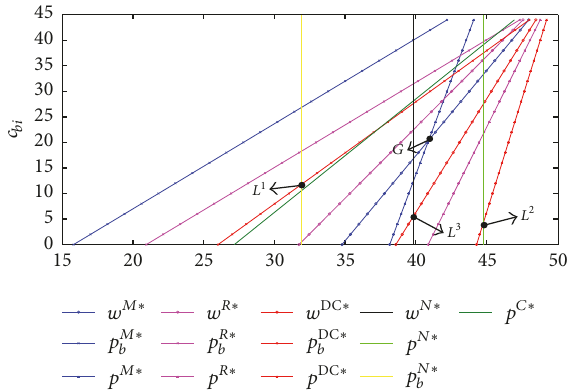
Figure 4: Effects of 𝑐 𝑏𝑖 on the pricing strategies of supply chain members.